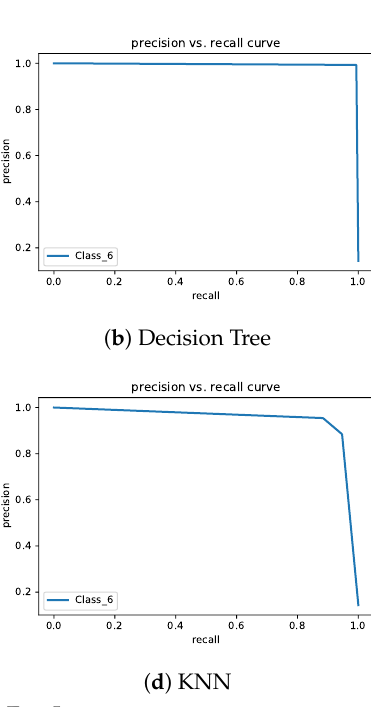
Figure 7. Confusion matrices for Exp-II.